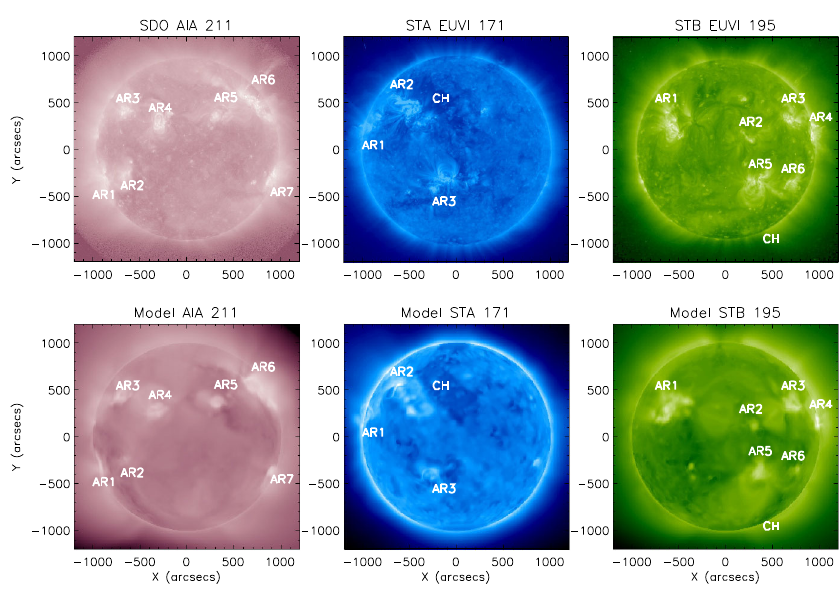
Fig. 19 Top panels (left to right): observational images from SDO/AIA 211Å, STEREO A/EUVI 171Å, and STEREO B/EUVI 195Å. The observation time is 2011 March 7 20:00 UT (CR2107). Bottom panels: synthesizedEUVimagesofthemodel.Activeregionsandcoronalholesaremarkedinboththeobservational and synthesized images, to demonstrate the reproducibility of the observed morphological structures in our simulations. Image reproduced with permission from Jin et al. (2017), copyright by